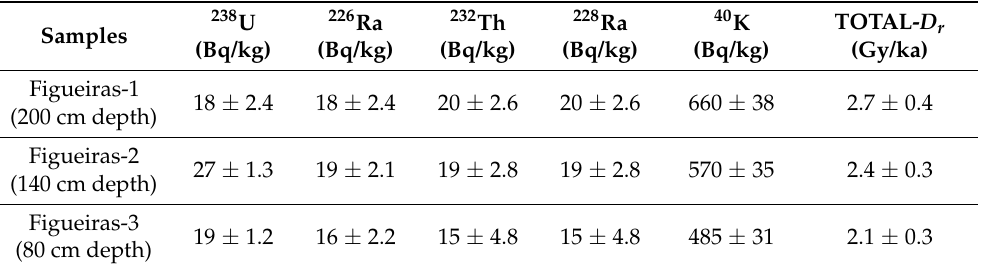
Table 2. Dose-rate estimation of the samples from aeolianite outcrops of the Cies Islands. Radioiso- topic activity of the series of 238 U and 232 Th ( 226 Ra and 228 Ra values are also shown), and 40 K (Becquerel/kg); Dose rate (Total- D r ) (Grays/ka). Sampling distance (cm) from the top to the base of the outcrop.